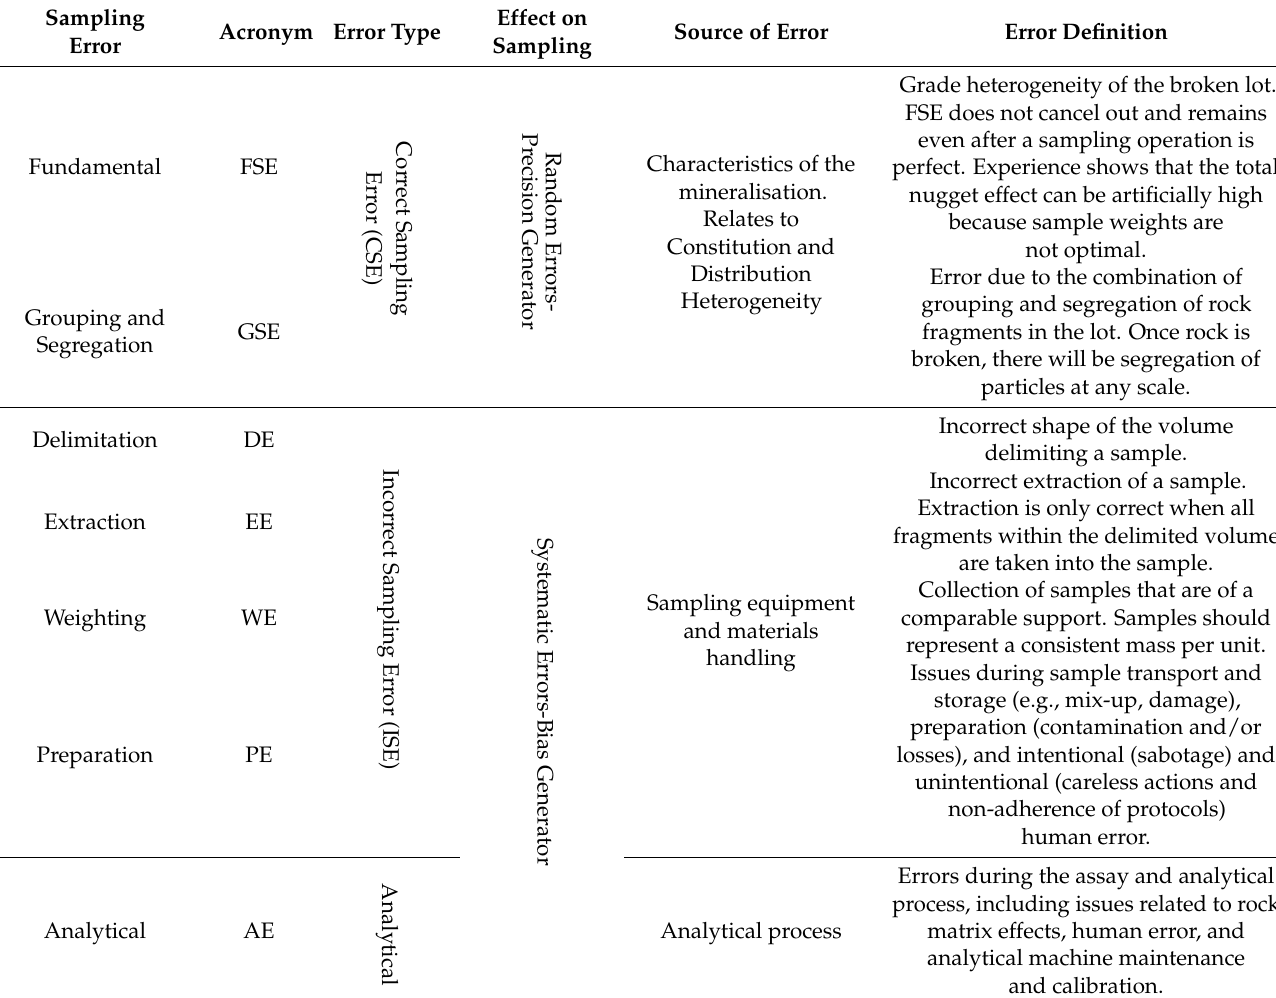
Table 1. Definition of TOS sampling